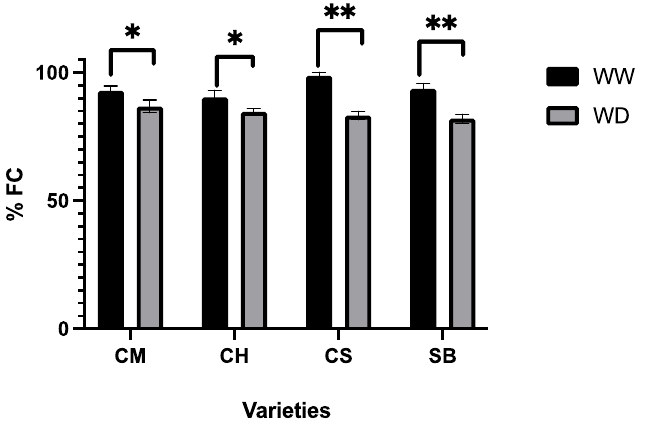
Figure 2. Average water content, as Field Capacity (FC) for WW and WD on Carmenere (CM), Chardonnay (CH), Cabernet sauvignon (CS) and Sauvignon blanc (SB). Single asterisk represents significant differences between treatments for each variety p ≤ 0.05. Double asterisk represents significant differences between treatments for each variety p ≤ 0.01. Table 1. Gas Exchange and water potential values of grapevine cultivars under two irrigation treat- ments. An, assimilation rate, gsw, stomatal conductance, Y pd 10 , pre-dawn water potential at 10 days after